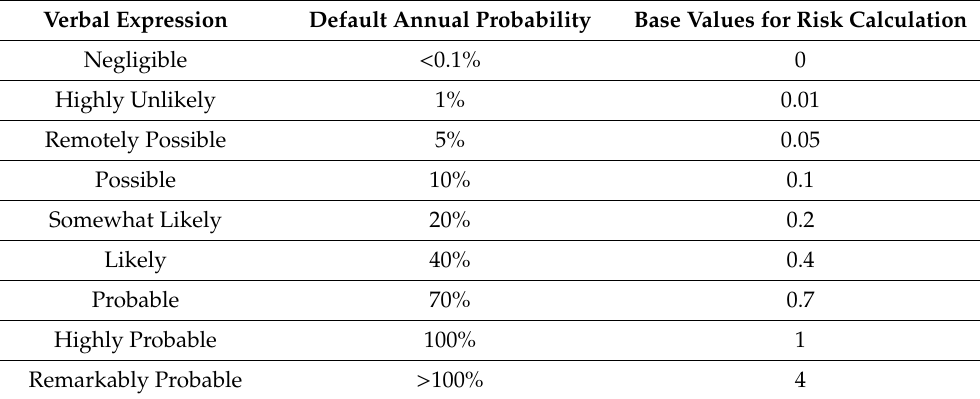
Table 3. Discrete classes of “TCEs”, “Hazards”, and “Probability of Hazards Occurring on Subsystems” nodes used in the discrete model (expressed as annual probability of occurrence).